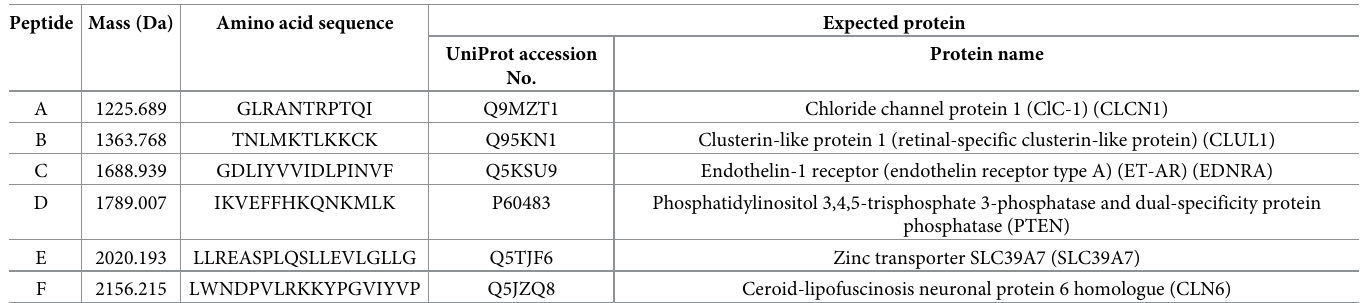
Table 2. Amino acid sequence of peptide candidates from Fig 4 analysed by LC-MS/MS. Peptide Mass